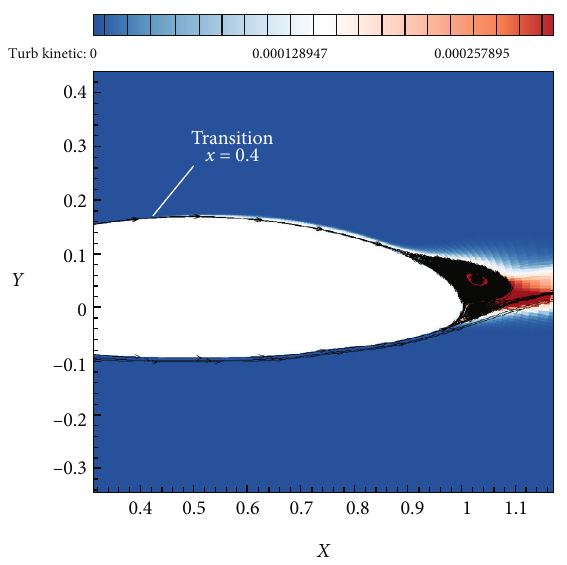
Figure 35: Turbulent kinetic energy distribution of DBLN-526 airfoil ( Re = 1 : 4 E 6 , α = 10 °